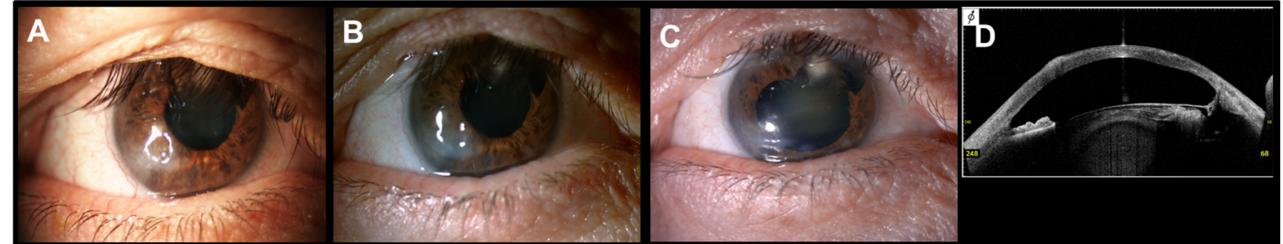
Figure 3. Corneal ulcer of a patient with Salzmann’s nodular degeneration treated with PRGF eye drops and RGTA. ( A ): Baseline situation. ( B ): Corneal image obtained after one month of follow-up, the corneal ulcer is under closure process. ( C ): Complete corneal ulcer closure after three cycles of PRGF eye drops. ( D ): OCT-SA image, restoration of corneal integrity maintained along the follow-up period (80.5 months).